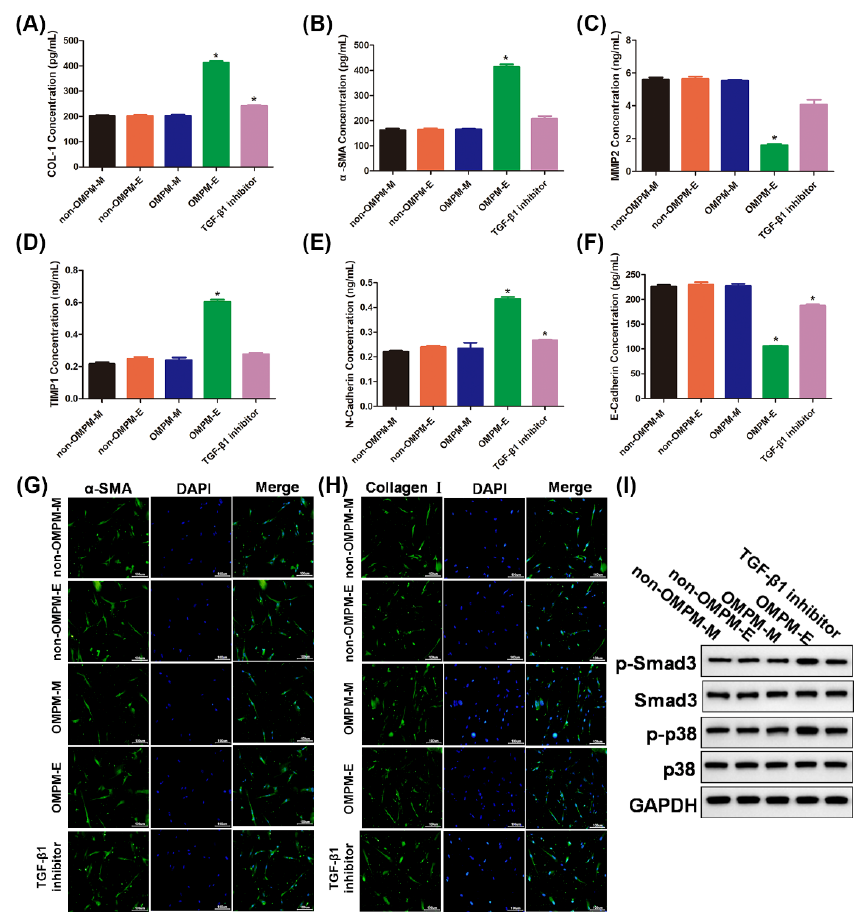
OMPM-E group of the BEAS-2B cell line, indicating that the OMPM-exposed BEAS-2B cell line could activate the TGF- β 1/Smad3 and TGF- β 1/p38 MAPK signaling pathways (Figure 6I). The results confirm our hypothesis that the OMPM-exposed BEAS-2B cell line could promote the activation of the TGF- β 1/ Smad3 and TGF- β 1/p38 MAPK signaling pathways and lung fibrotic differentiation phenotypes in the HFL-1 cell line. The activation of the TGF- β 1/ Smad3 and TGF- β 1/p38 MAPK signaling pathways, and lung fibrotic differentiation phenotypes in the HFL-1 cell line can be regarded as the initial event of PF in vitro [38,39].